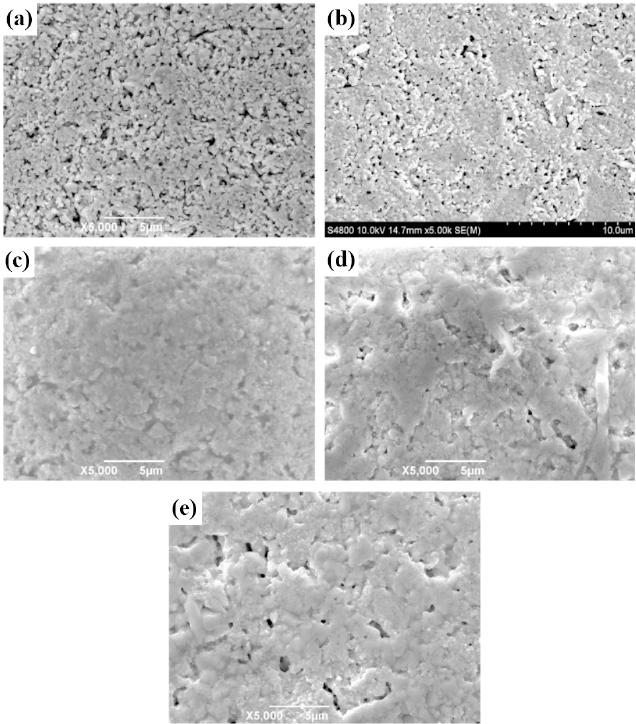
Figure 9. The surface microstructure of the BST@Fe 2 O 3 ceramics with different coating amounts ( a ) 0 wt%, ( b ) 2.5 wt%, ( c ) 5 wt%, ( d ) 7.5 wt%, and ( e ) 10 wt%.